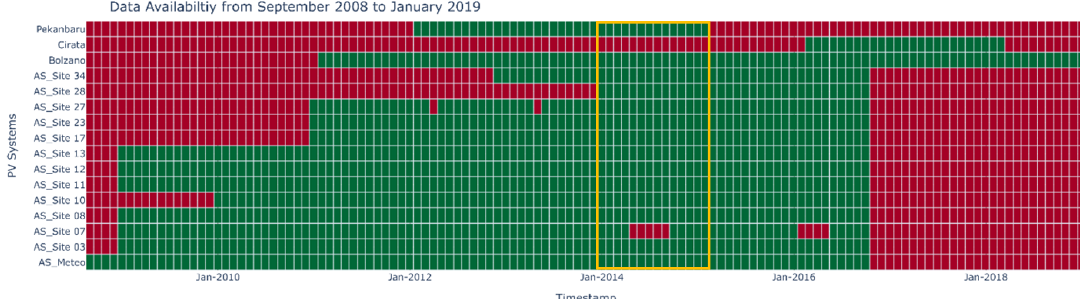
Figure 3. The period of data availability for each PV system; green: data is available, red: data is not available.